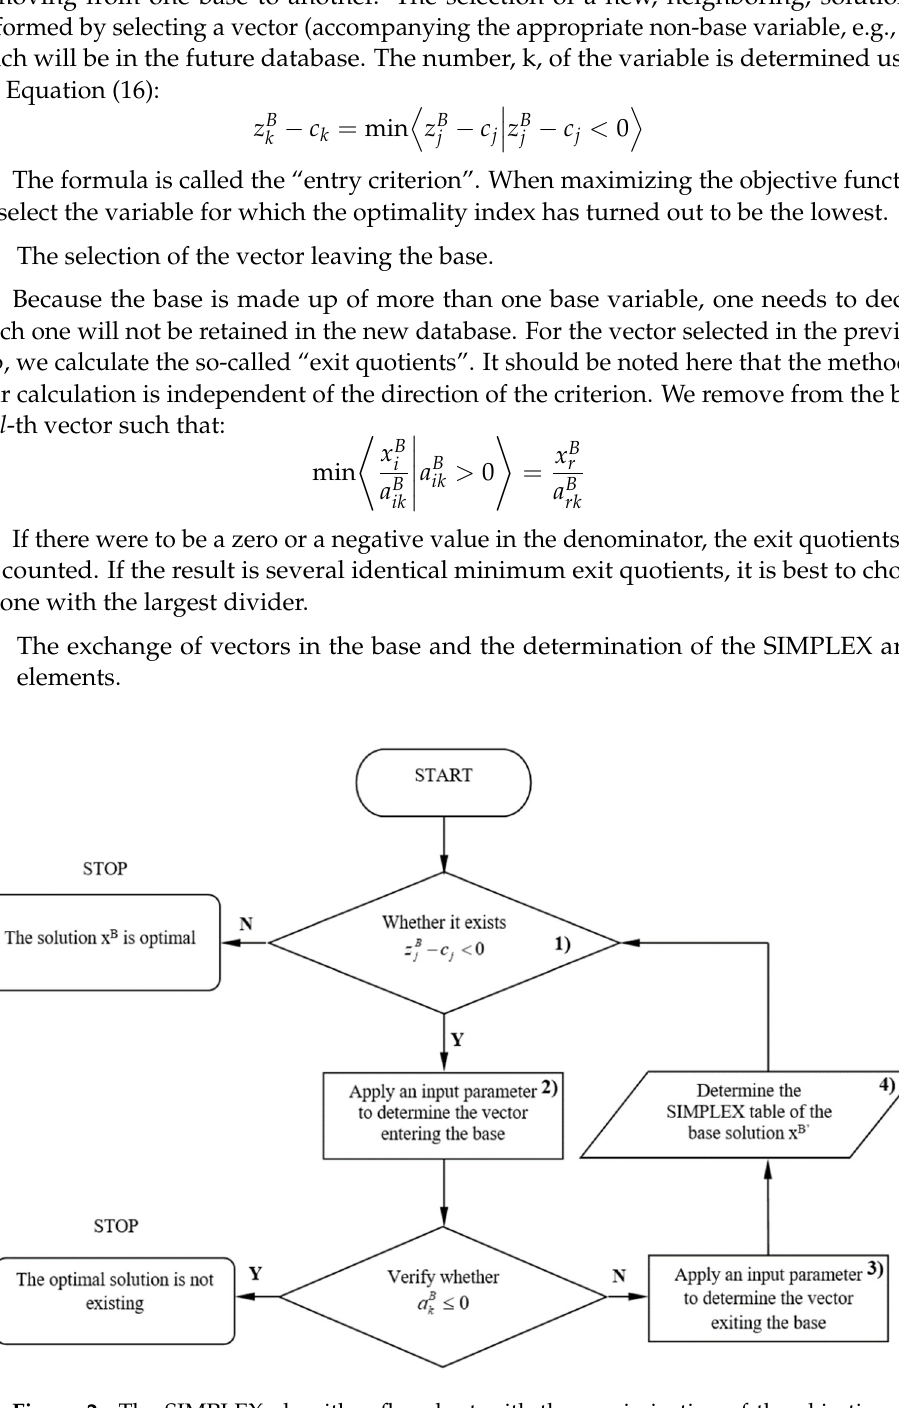
Figure 2. The SIMPLEX algorithm flowchart with the maximization of the objective function.